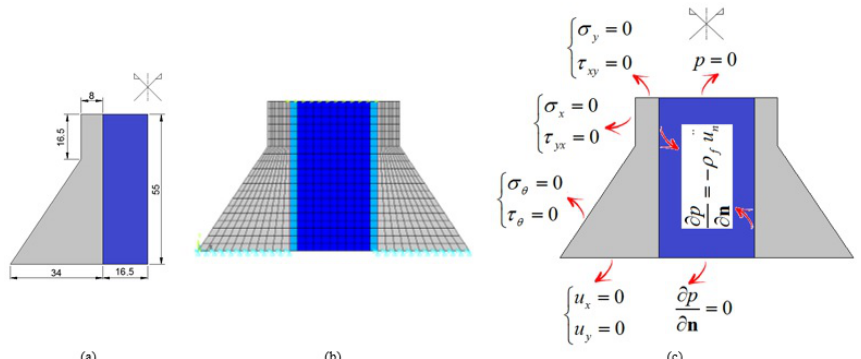
Figure 3. (a) Left part of the symmetrical lock-tank system. Measured in meters. (b) Model of the lock system. (c) Boundary conditions adopted in the lock